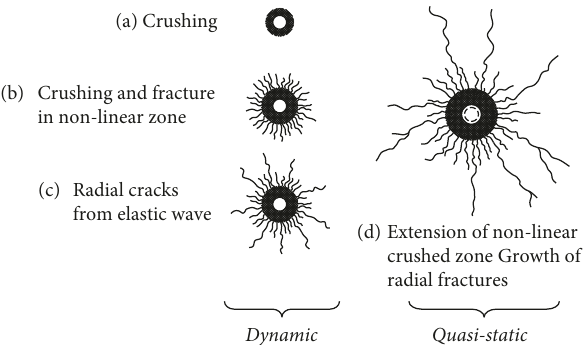
Figure 1: The evolution of fracture patterns at the consecutive stages in the fracture process of one-borehole blasting